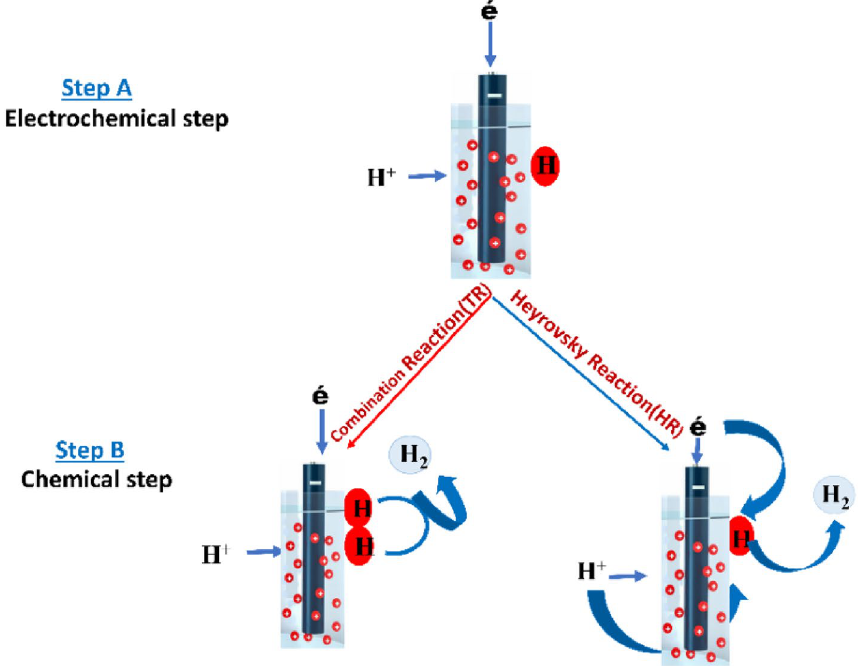
Figure 10. Hydrogen evolution reaction mechanism of reaction on the surface of a conducting pole